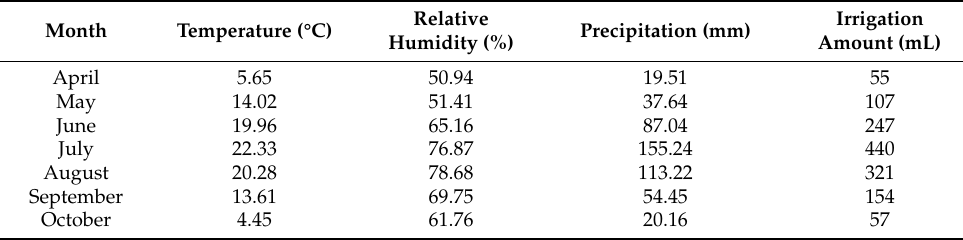
Table 1. Simulated climatic parameters of the control group during the